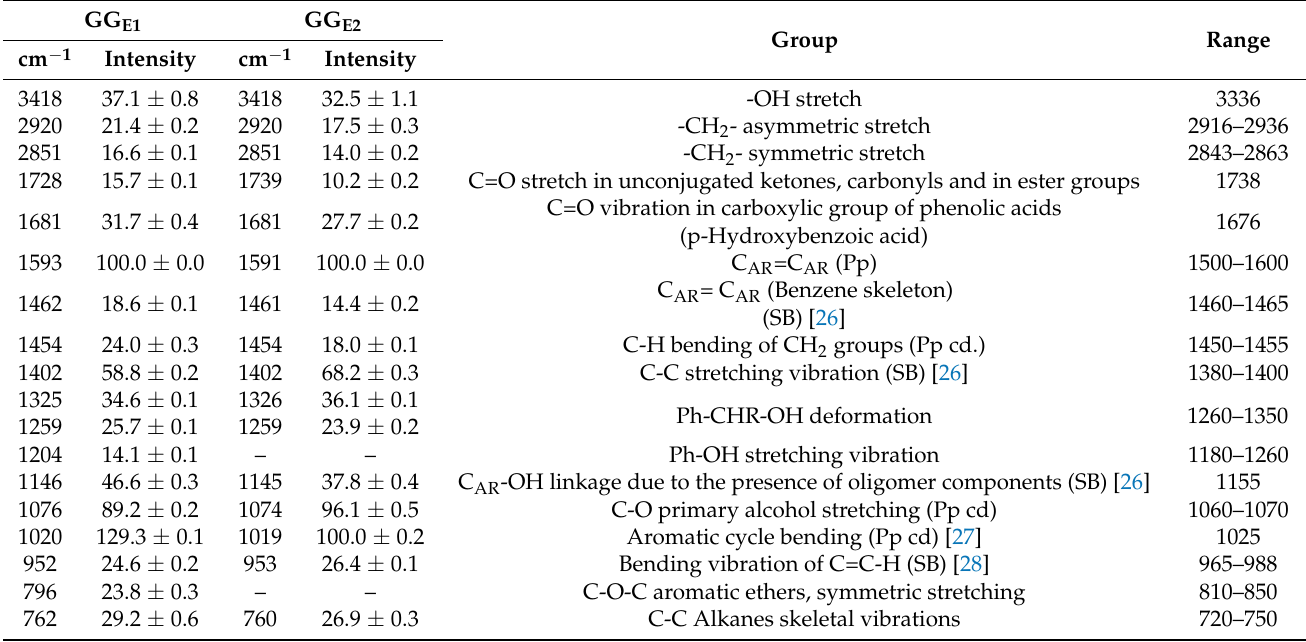
Table 4. FTIR peak assignment of grape cane extracts GG E1 and GG E2